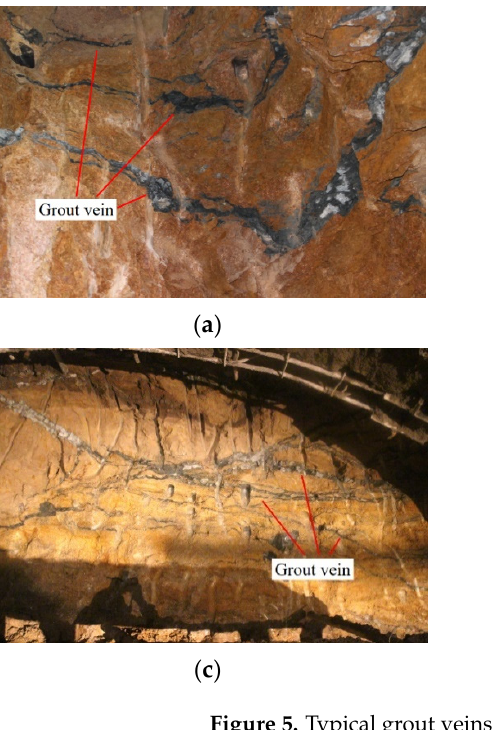
Figure 5. Typical grout veins in sand grouting projects of Qingdao metro line. ( a ) Beer-miao running tunnel in Qingdao metro line 2. ( b ) Shilaoren station in Qingdao metro line 2. ( c ) Taishan station in Qingdao metro line 4. ( d ) Jia-ling running tunnel in Qingdao metro line 13.